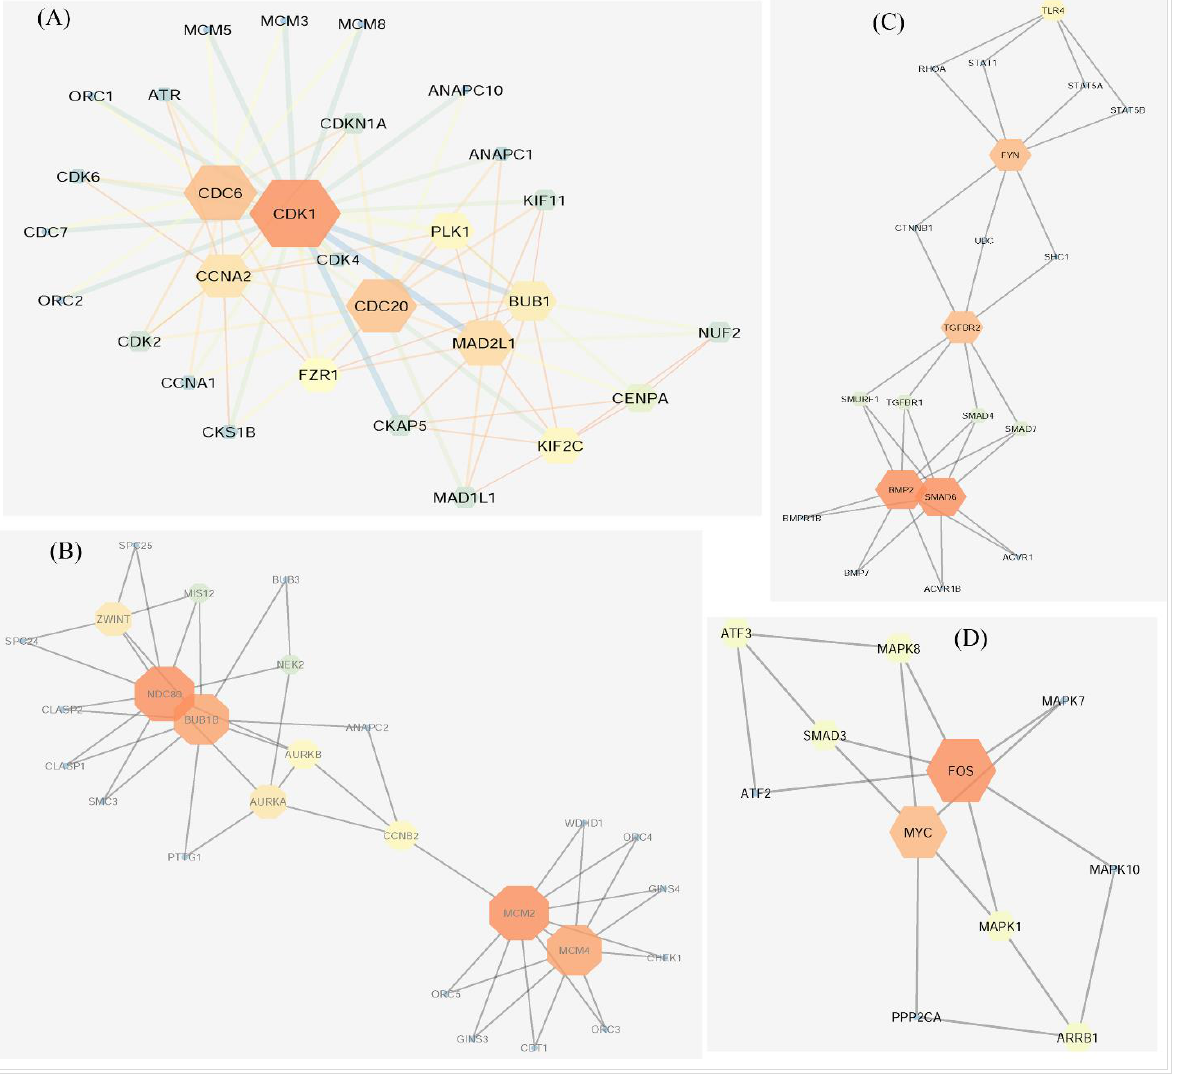
Figure 4. The first four sub networks based on score, identified by the MCODE algorithm. The scores of 6.071, 3.76, 3.684, and 3.4 were exhibited by the ( A ) first, ( B ) second, ( C ) third, and ( D ) forth sub modules, respectively.